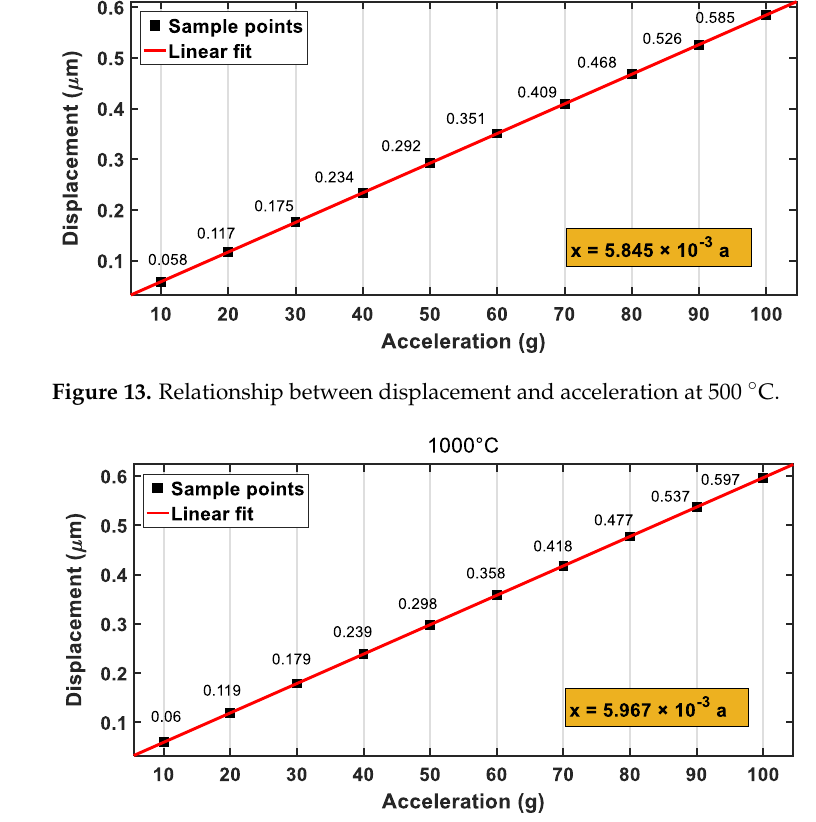
Figure 14. Relationship between displacement and acceleration at 1000 °C.